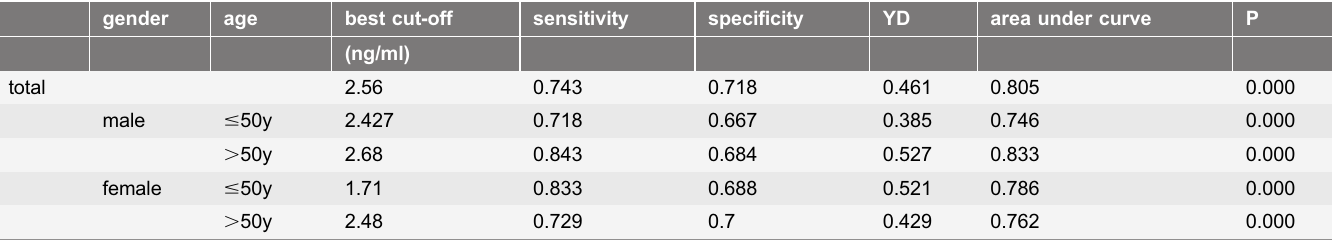
Table 7. Efficiency of serum OPN in discriminating gastric cancer. gender